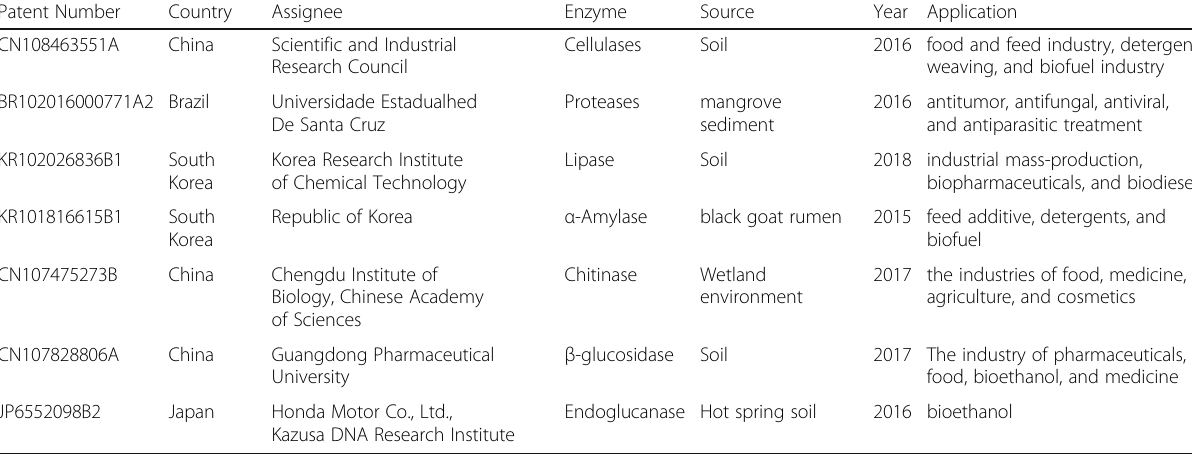
Table 3 Examples of patented enzymes from metagenome source in the past 5 years Patent